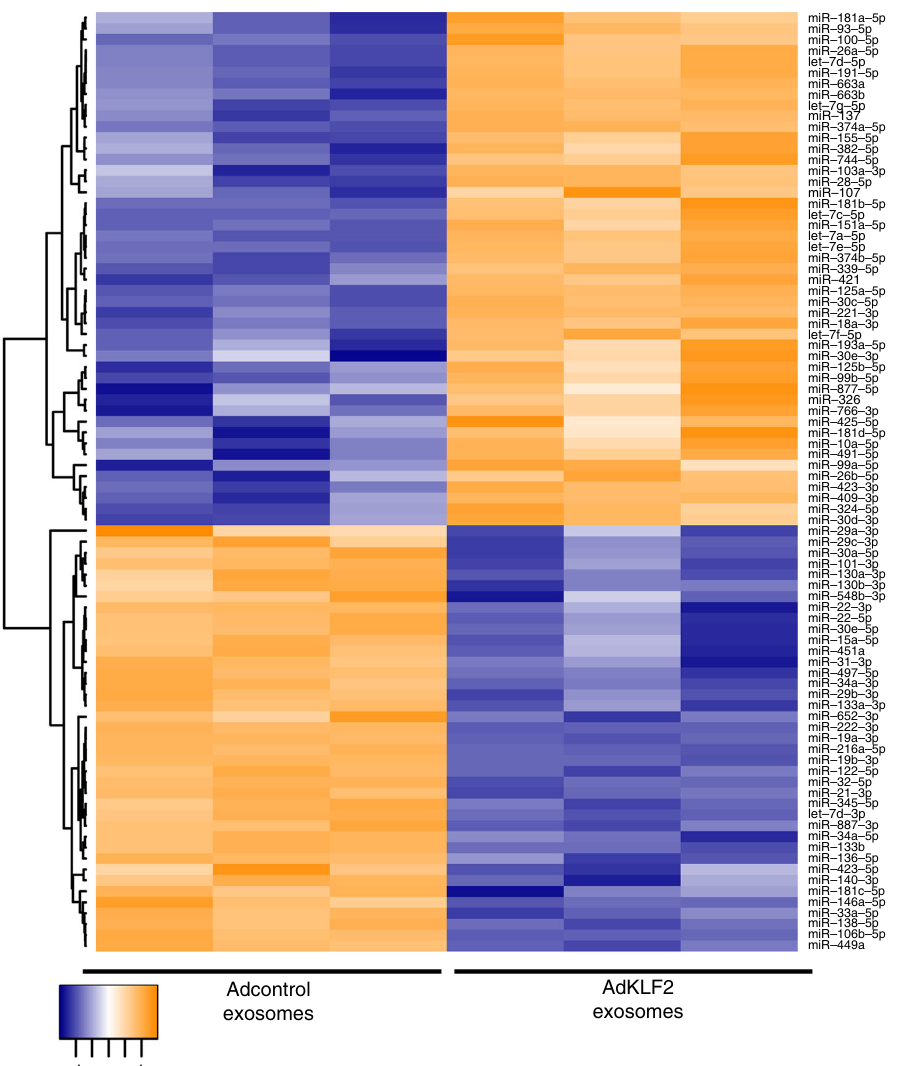
Fig. 2 KLF2-induced changes in exosomal miRNA expression. a Heat map and unsupervised hierarchical clustering. The clustering was performed on three samples of exosomal pellets collected 24 h post-infection with AdGFP or AdKLF2-GFP. Each row represents one miRNA, and each column represents one sample. The miRNA clustering tree is shown on the left. The colour scale illustrates the relative expression level of an miRNA across all samples: yellow colour represents an expression level above mean and purple colour represents expression lower than the